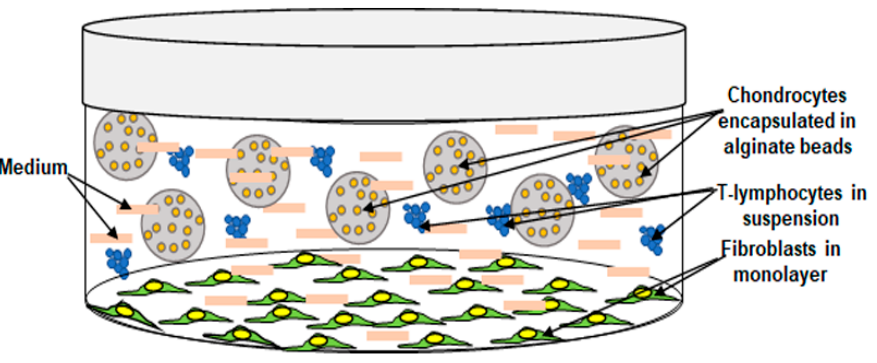
Figure 1. Graphical image showing the basis of the cultural setting of the osteoarthritic environment. 2.1. Curcumin Antagonizes Osteoarthritic Environment-Attenuated Chondrocyte Proliferation, The Same as with NF-kB-ASO or a Targeted IKK